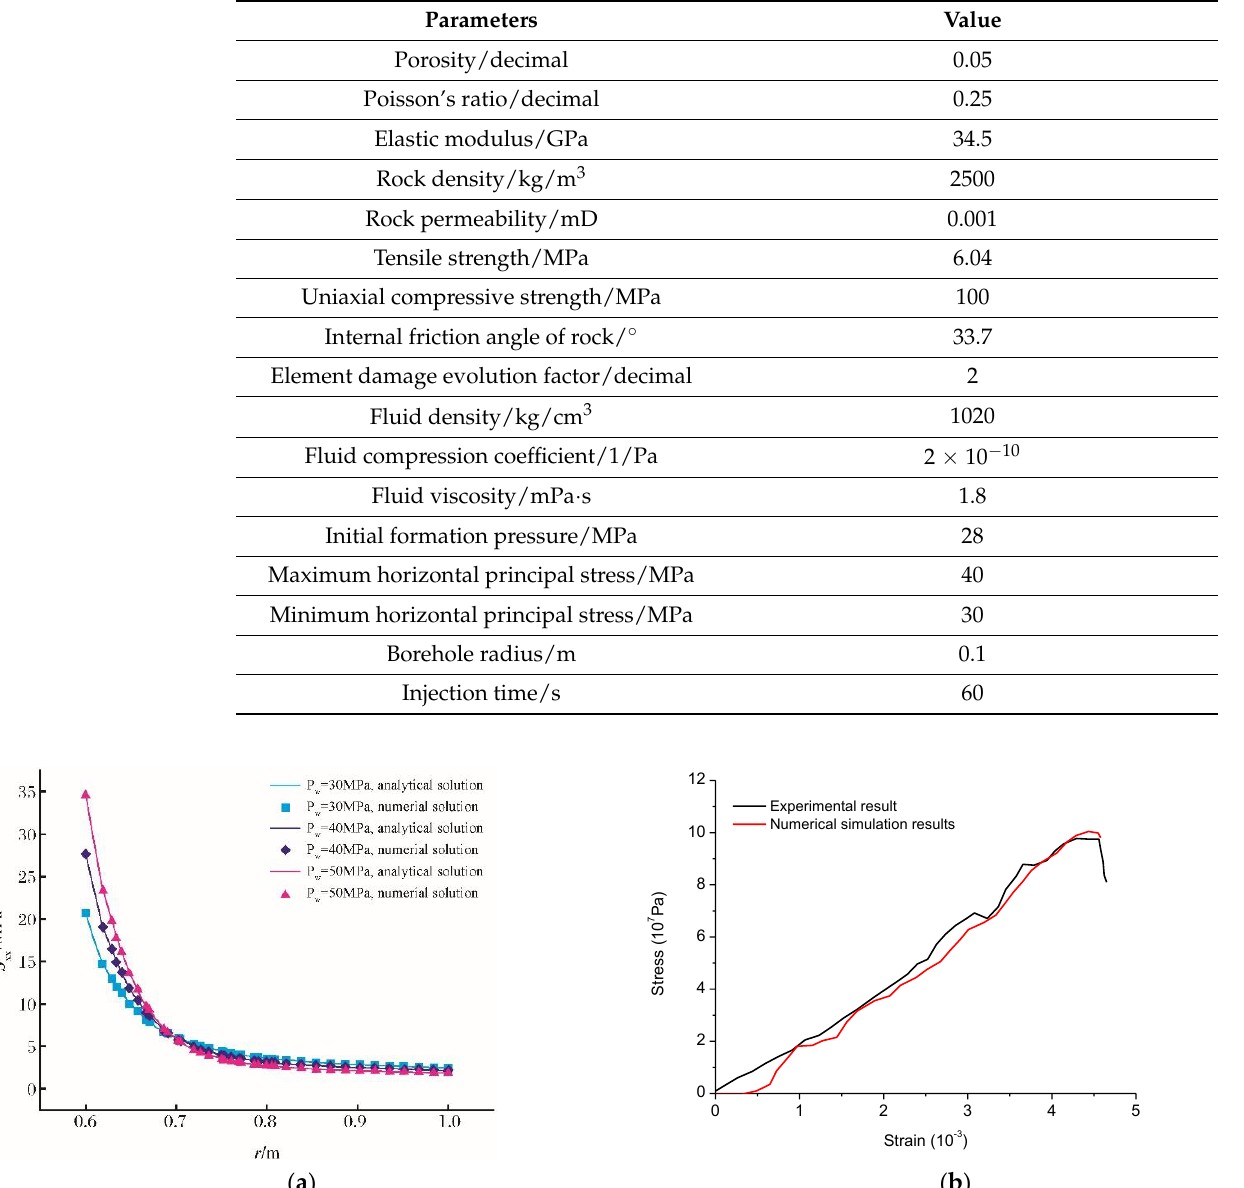
Table 1. Input parameters.